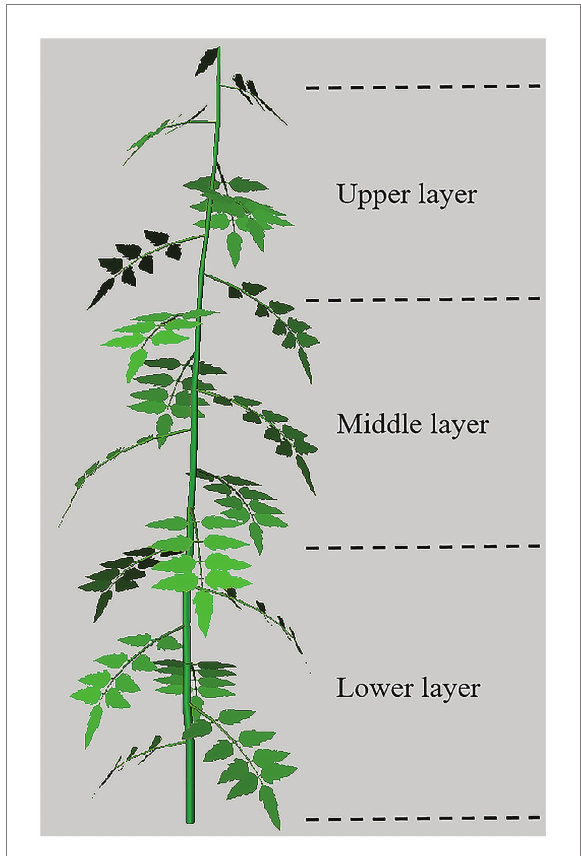
FIGURE 2 Snapshot of a single tomato plant with 18 internodes and leaves, having a total length of 1.8 m, divided into three layers: upper, middle, and lower layer, each of a layer of 6